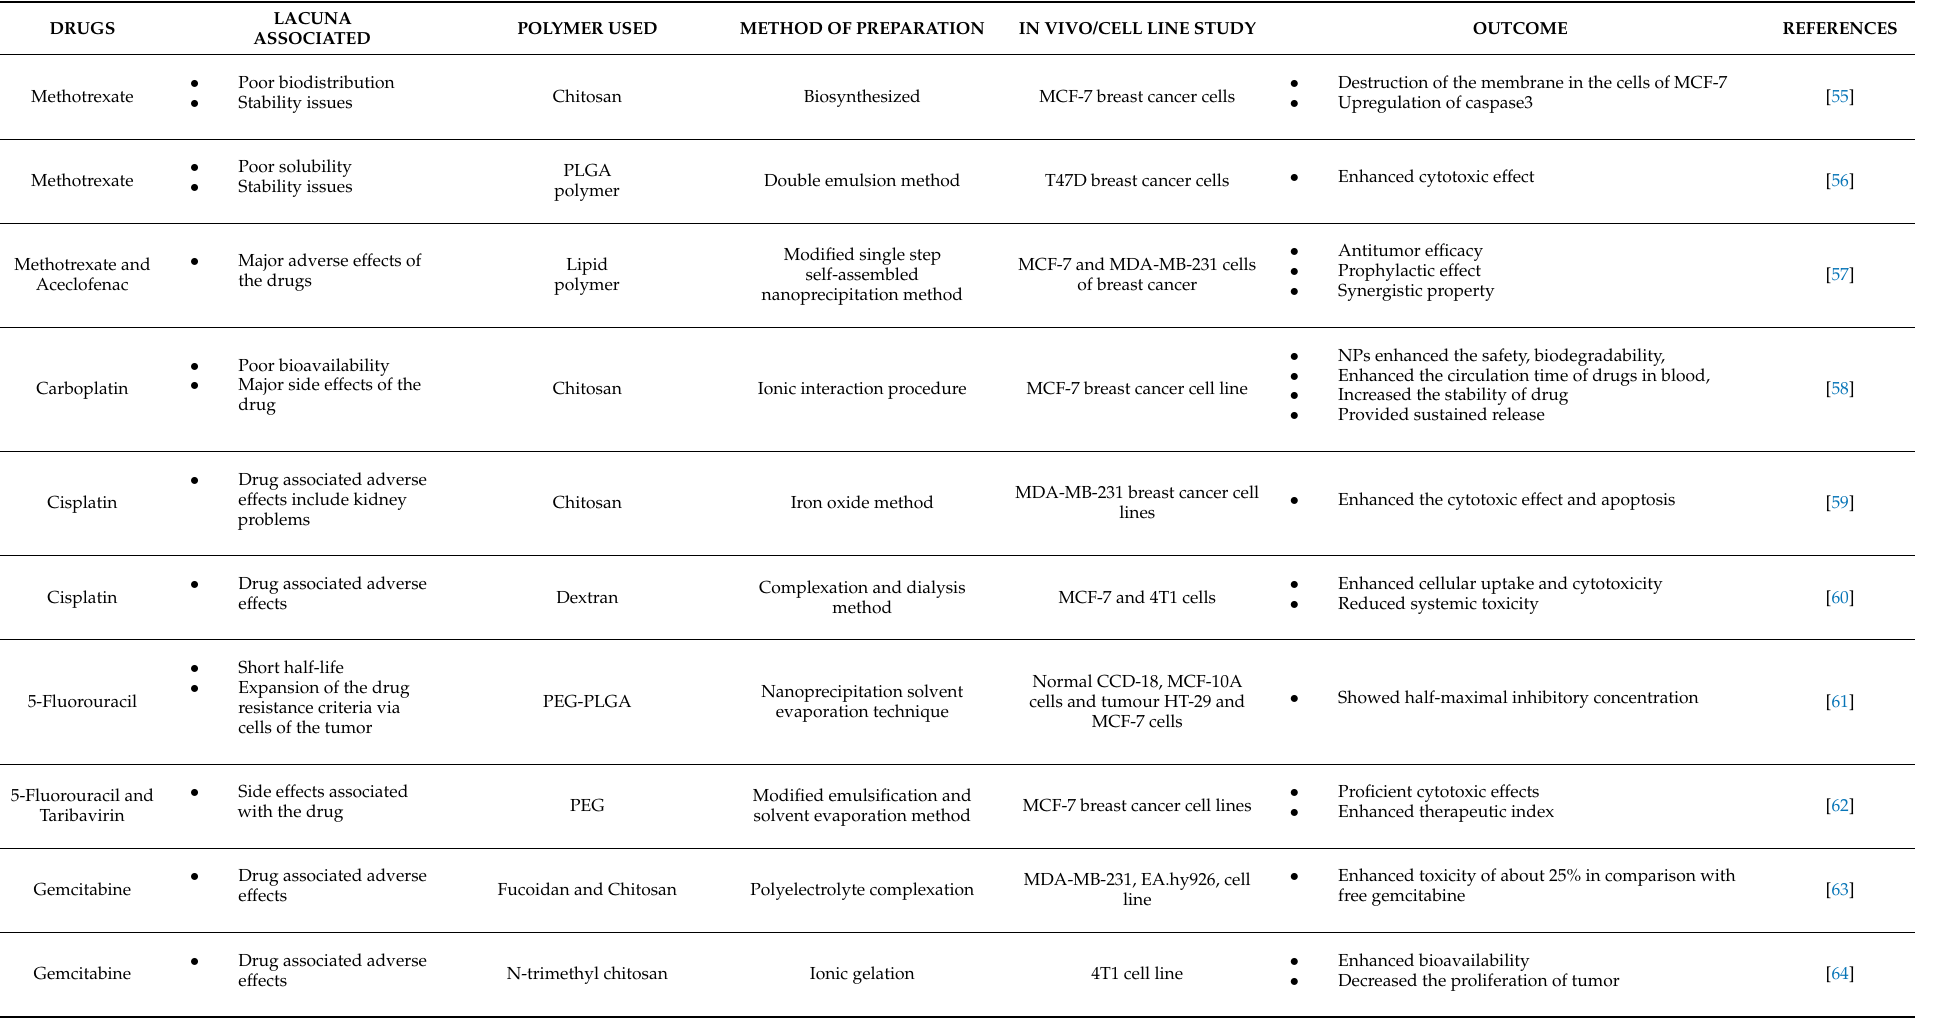
Table 4. Methotrexate, Platinum, Fluorouracil, Gemcitabine and CDK4/6 based chemotherapy and their combination polymeric nanoparticles for breast cancer treatment.